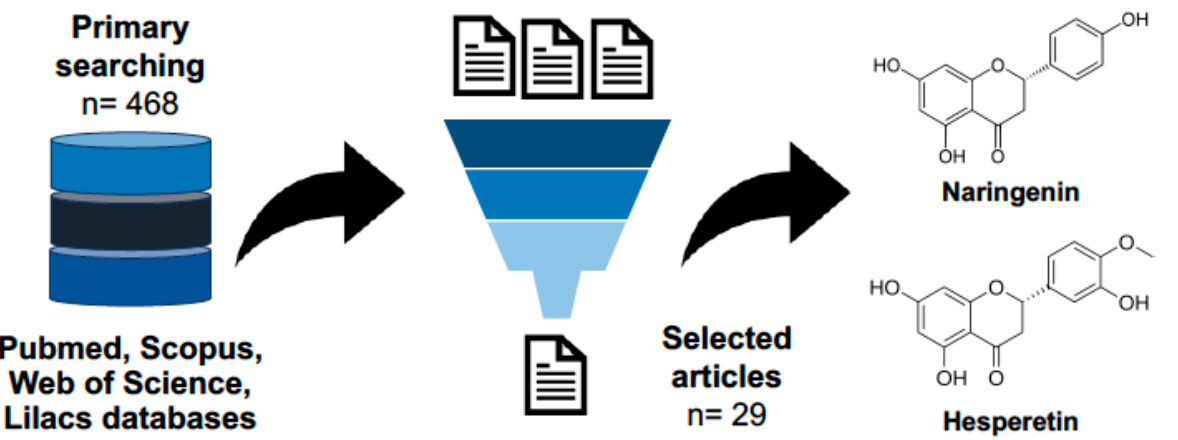
Figure 3. Graphic representation of the methodological process applied to perform this systematic review.